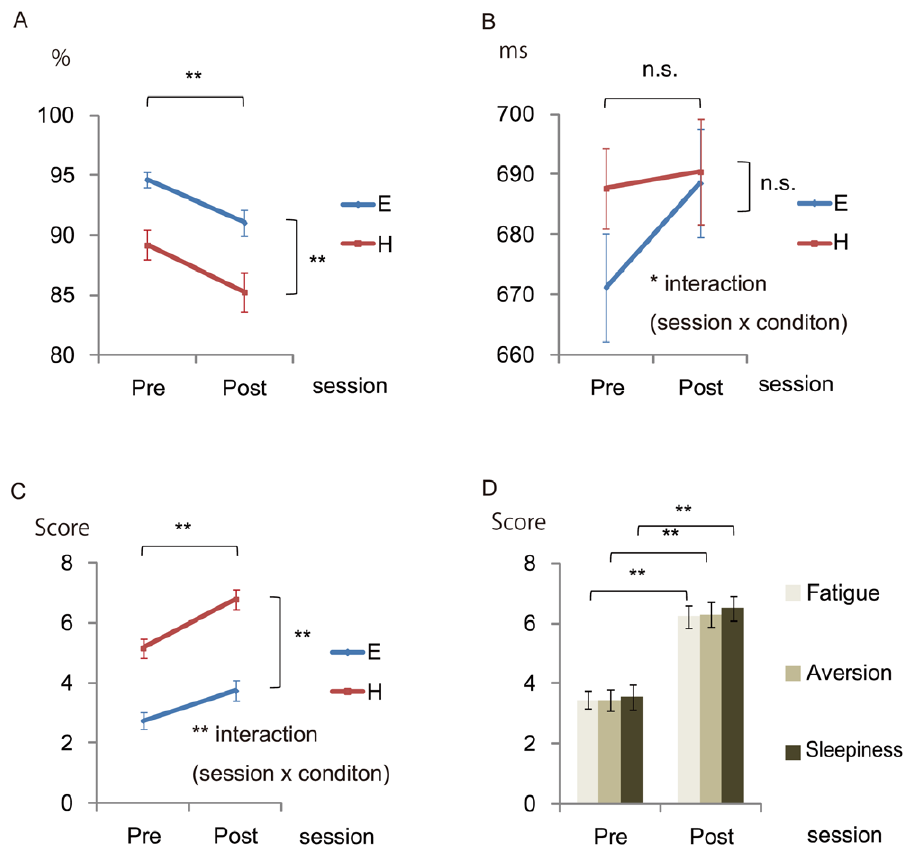
Figure 2. Behavioral data (n=29). The mean percent accuracy (A) and mean reaction times (B) in both Pre and Post sessions during functional MRI scanning are shown for the easy and hard conditions. Each line indicates the subjective task difficulty of the easy and hard tasks, which were analyzed using a two-way ANOVA for factors Load (Easy vs. Hard) and Time (Pre vs. Post) (C). Each bar graph indicates the means of the subjective feelings of fatigue, aversion, and sleepiness in both Pre and Post sessions, which were analyzed using paired t -tests (D). Error bars indicate standard errors. * p , 0.05; ** p , 0.001. E, Easy; H, Hard; n.s., no significance; Post, the last three runs again in the magnetic resonance imaging (MRI) scanner; Pre, the first three runs in the MRI scanner.